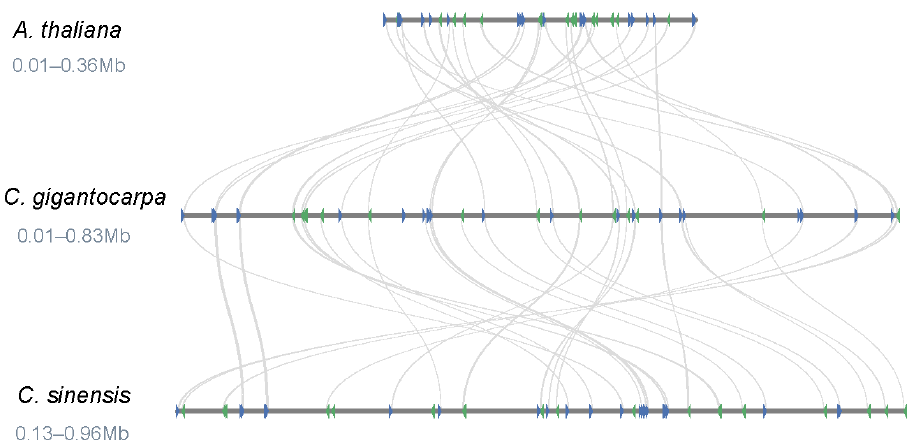
Figure 4. Synteny analysis of C. gigantocarpa , C. sinensis , and A. thaliana mitochondrial genomes.